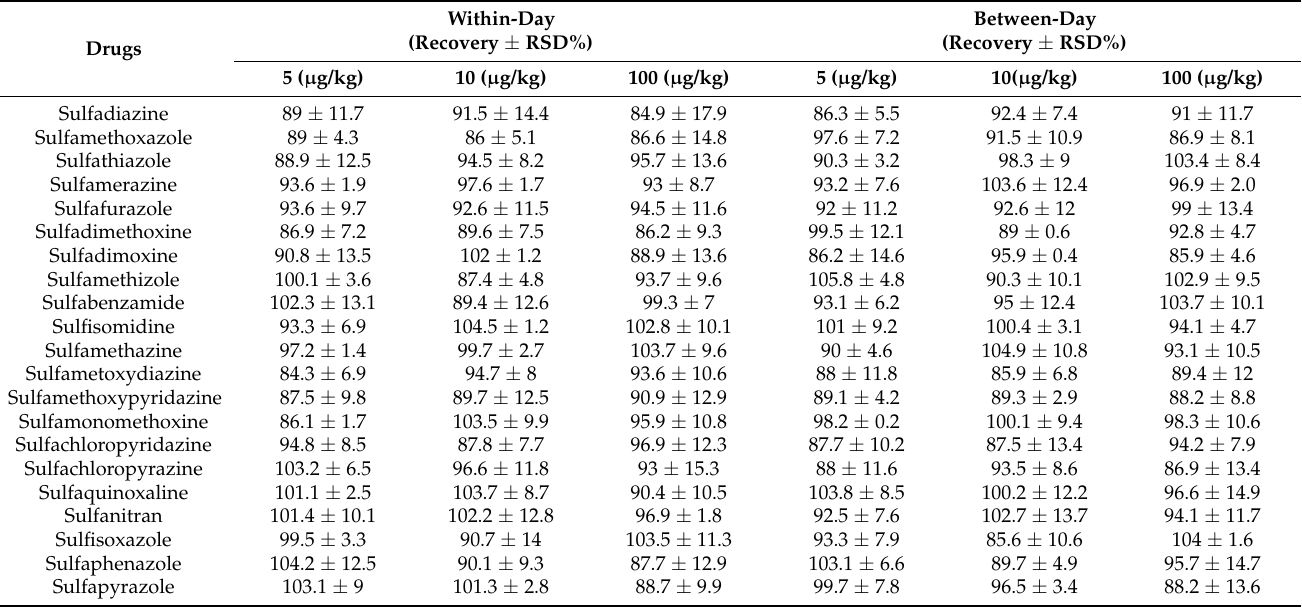
Table 3. Recovery of within-day and between-day for poultry eggs (n =